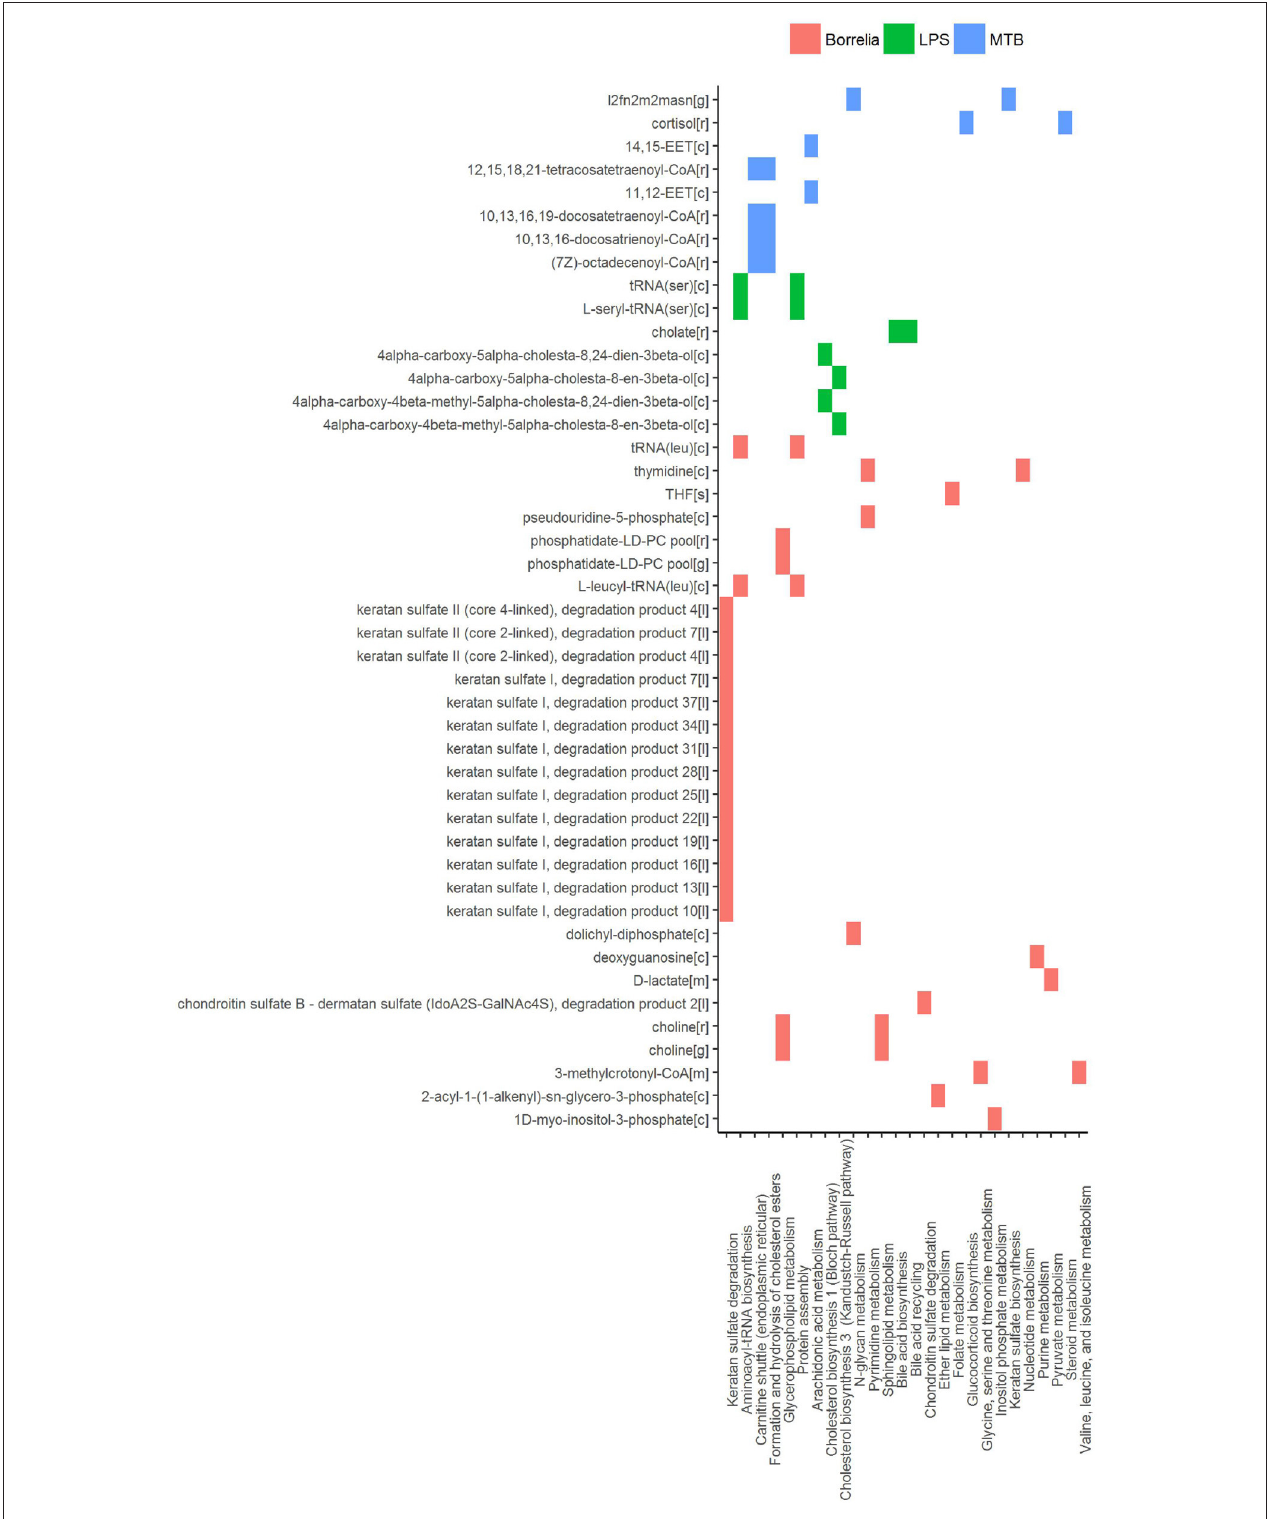
FIGURE 9 | Reporter metabolites that discriminated Borrelia , LPS, and MTB-stimulated PBMCs at 4 and 24 h. Associated subsystems of these reporter metabolites are identified in HMR2.